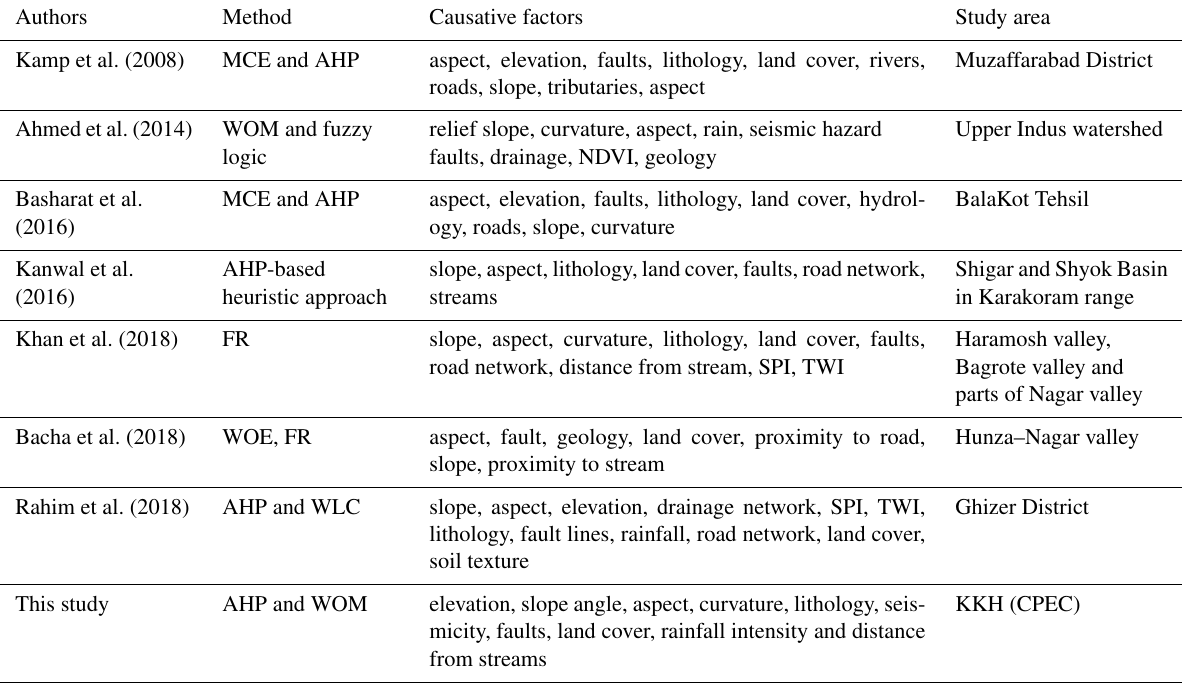
Table 1. Previous work in some parts of northern Pakistan. MCE is multi-criteria evaluation, NDVI is normalized difference vegetation index, SPI is stream power index, TWI is topographic wetness index, WOE is weight of evidence, and FR is frequency